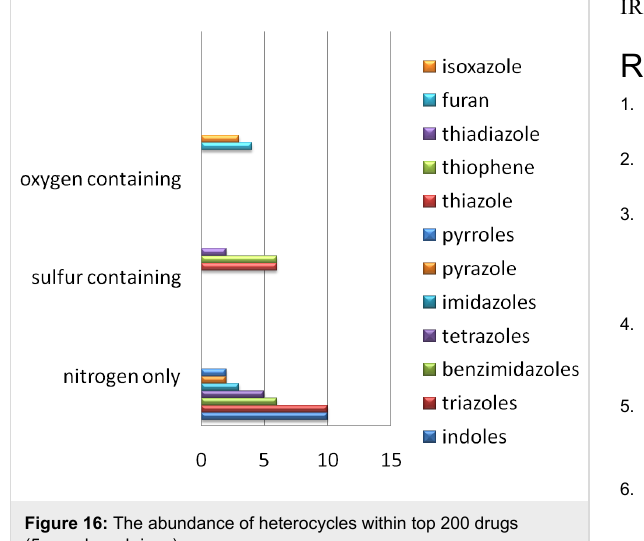
One constant in all the drug syntheses is the shortness of the reported routes, which typically do not exceed 6–8